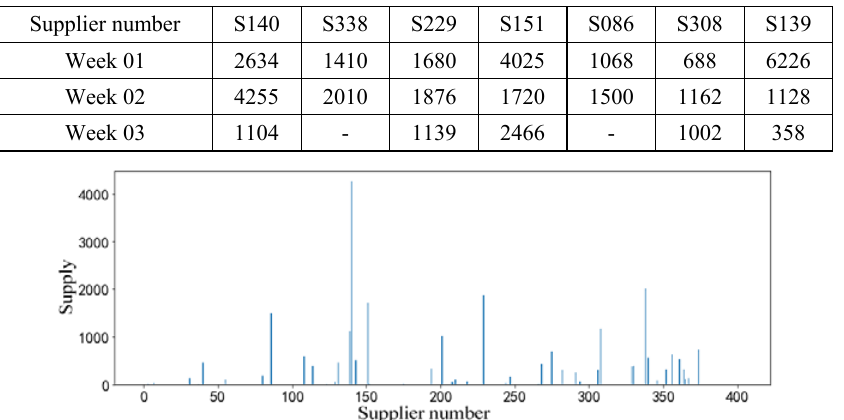
Table 2. Best procurement scheme (part)